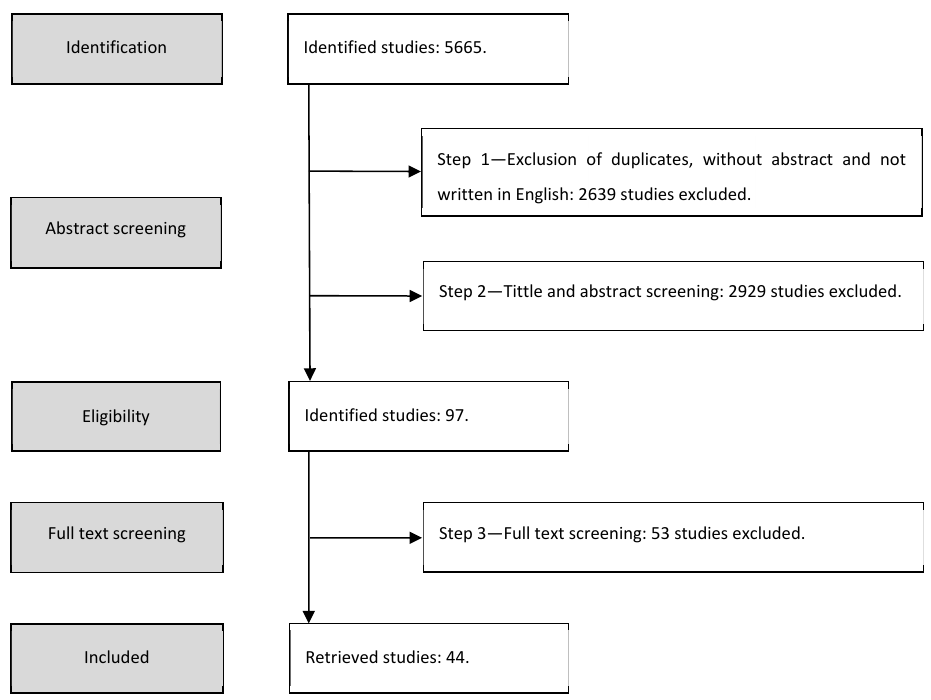
Figure 1. Systematic Reviews Flowchart.